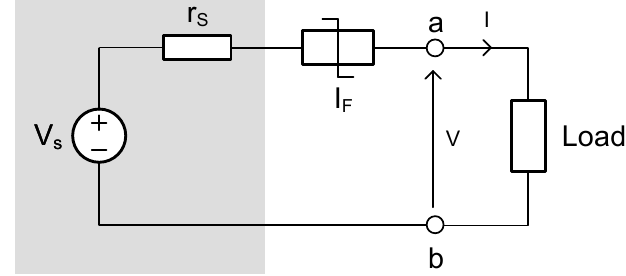
Figure 3. DC source with internal resistance and a fuse.